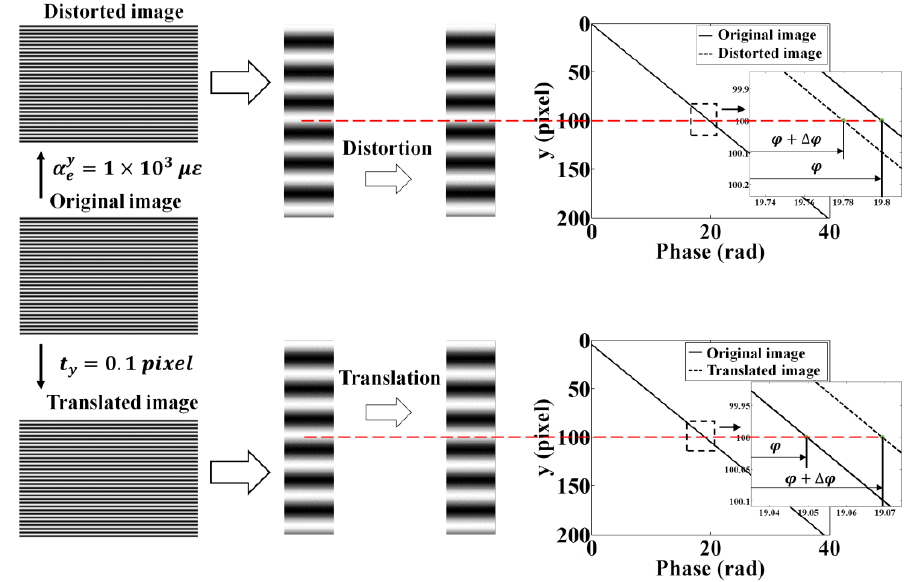
Figure 10. Investigation of relationship between the image error and measurement error of fringe analysis methods.